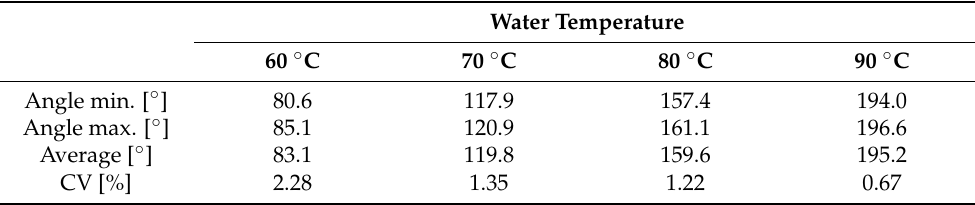
Figure 12. Determination of final transformation angles in water: ( a ) 60 ◦ C, ( b ) 70 ◦ C, ( c ) 80 ◦ C and ( d ) 90 ◦ C. Table 1. Transformation angles at different activation temperatures in hot